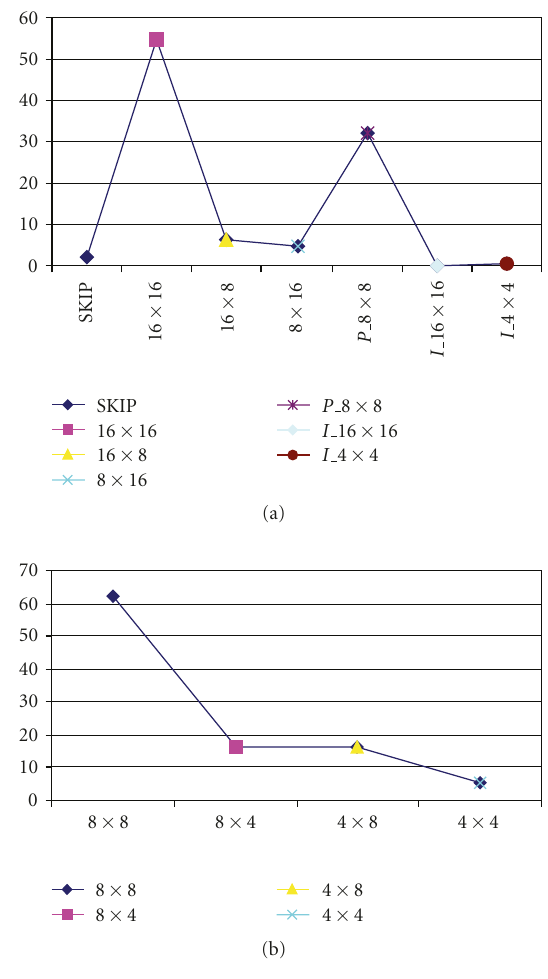
Figure 5: (a) Mobile. (b) Sub-MB of